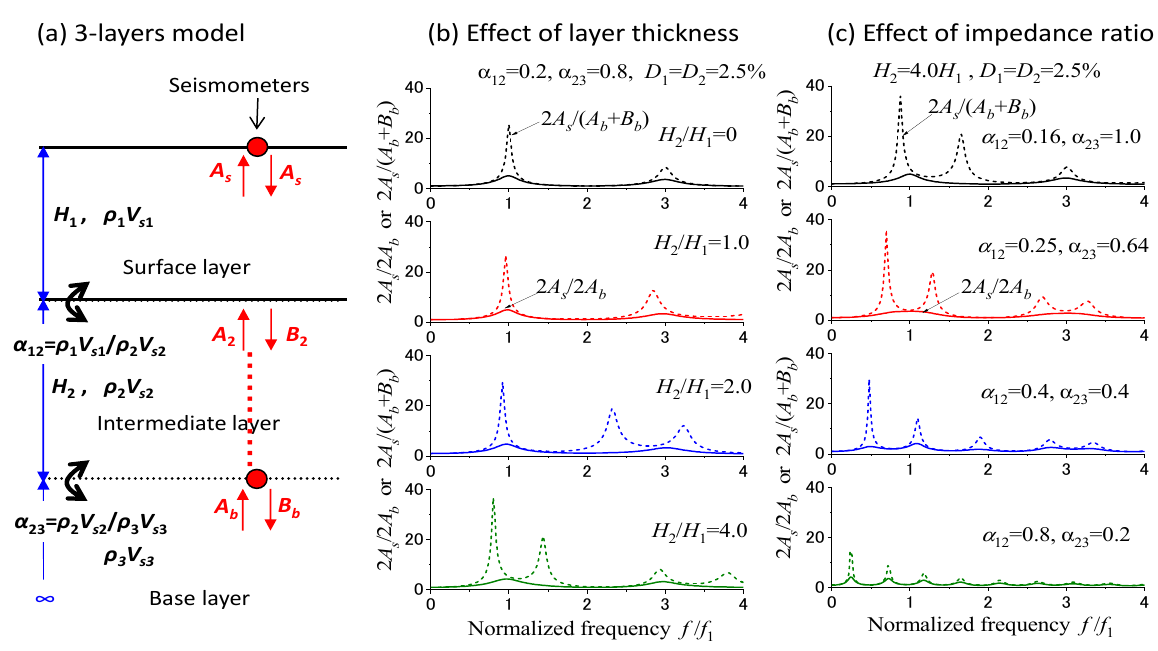
Figure 5. Three-layers system to compare (2 A s /( A b + B b )) versus 2 A s /2 A b ( a ). Computed results for varying layer thickness ( b ); computed results for varying impedance ratio ( c ).